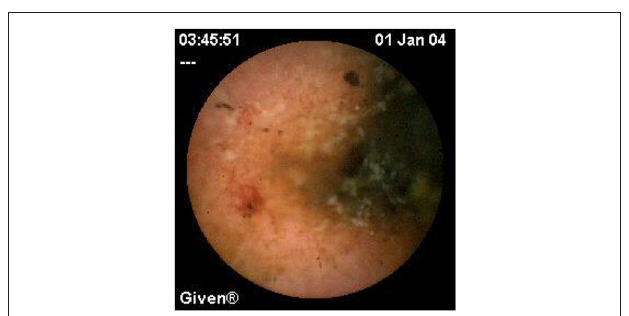
FIGURE 3 | Deep erosion (presumably Crohn’s).